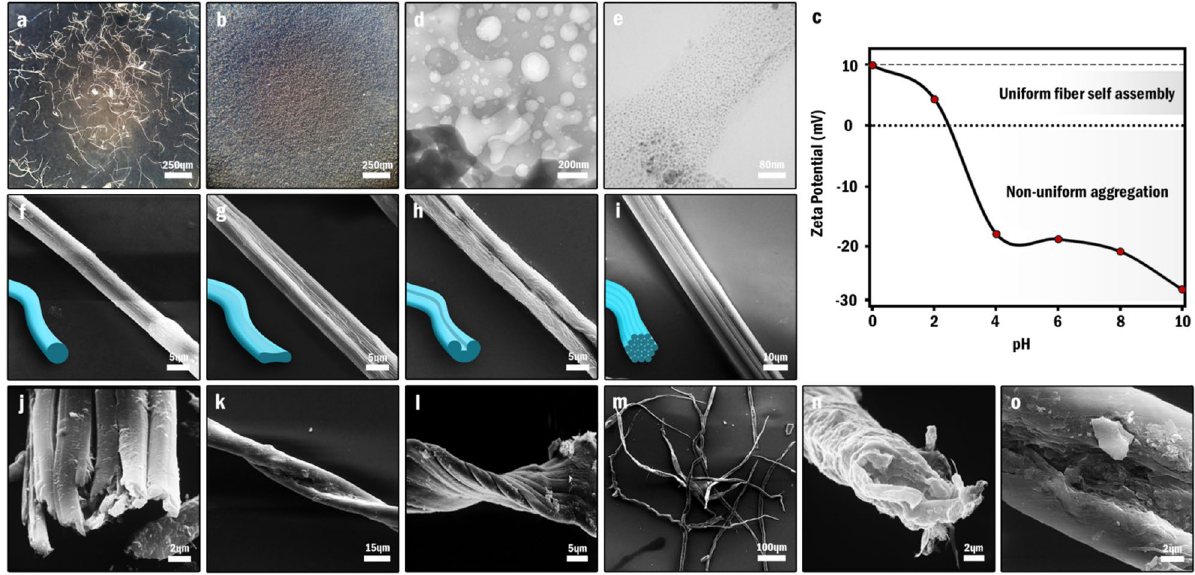
Figure 4. Transformation of NOG nanosheets into NOG fibers, ( a – b ) OM images of dried NOG fibers and unshaped flocculated particles on glass slide obtained from sonication of NOG nanosheets at pH: 0 and pH: 8 respectively. ( c ) Zeta potential of NOG dispersion (1 mg/mL) as a function of pH. ( d – e ) TEM images of the NOG nanosheets before sonication in acidic solution, and the resulting quantum dots after a 5 min-sonication in acidic solution (HCl 6 M) respectively. ( f – i ) SEM images of CF, CTF, KSF, and MSF respectively. ( j ) Cross- section SEM image of MSF ( k – l ) SEM images of twisted KSF and MSF. ( m ) A low magnification SEM image of NOG fibers ( n ) Cross-section SEM image of CTF ( o ) Extreme close-up SEM image of KSF indicating the porous structure of the central